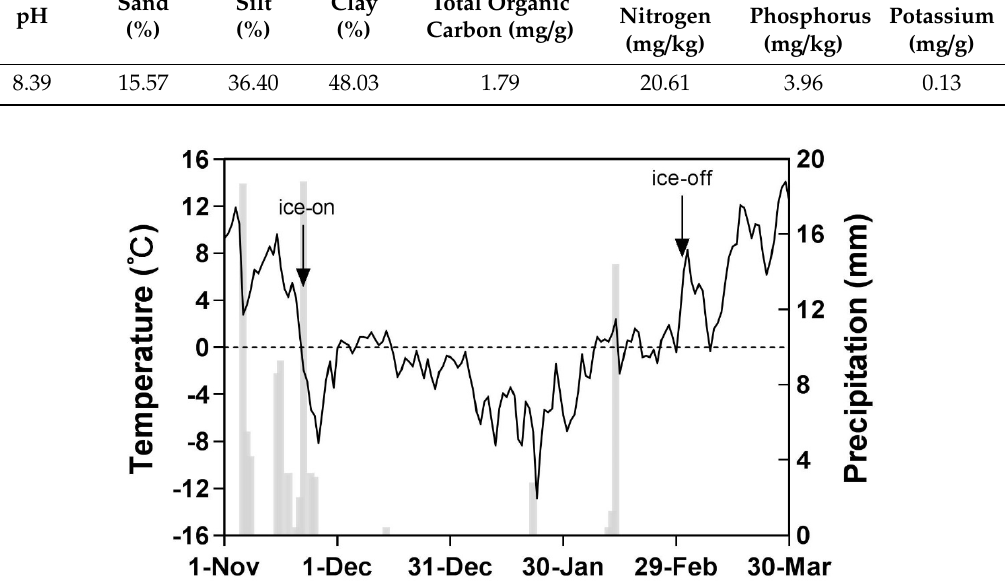
Figure A1. Dynamics of air temperature and precipitation from 1 November 2015 to 30 March 2016 at Hengshui Lake.